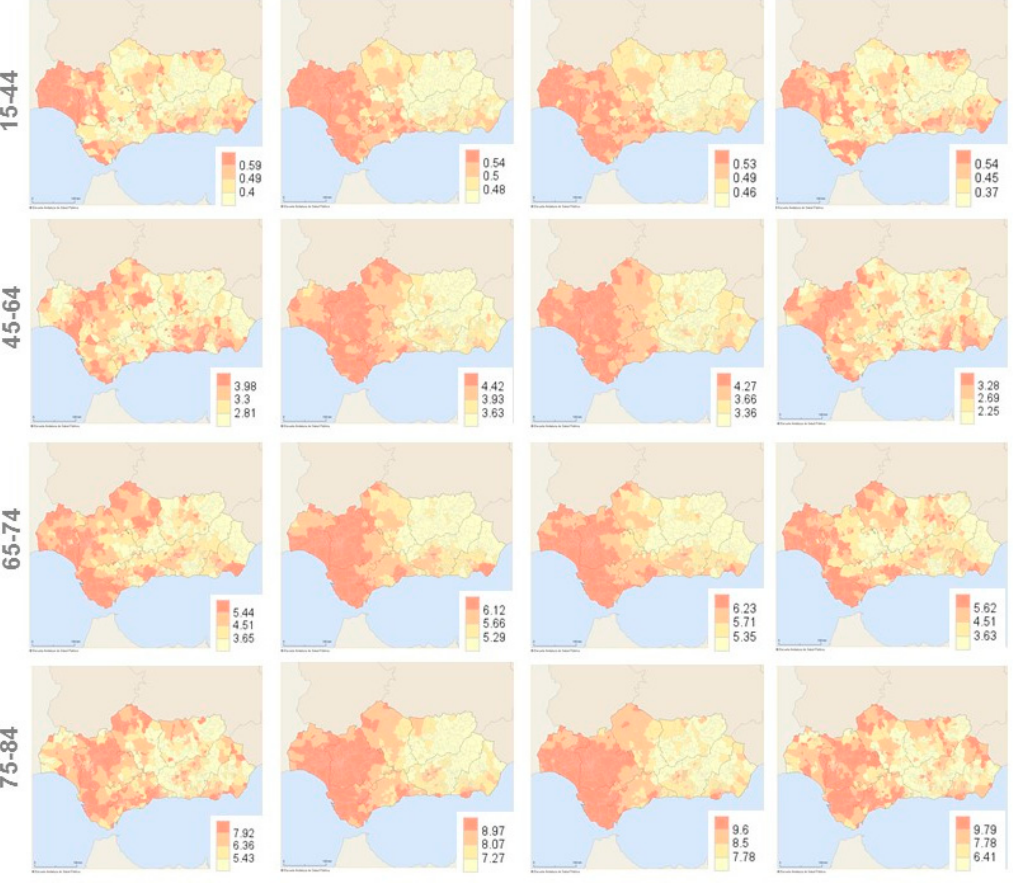
Figure 5. Geographical variations of age-specific mortality rate per 10,000 women from female breast cancer in the municipalities of Andalusia (southern Spain), 1981–2012.